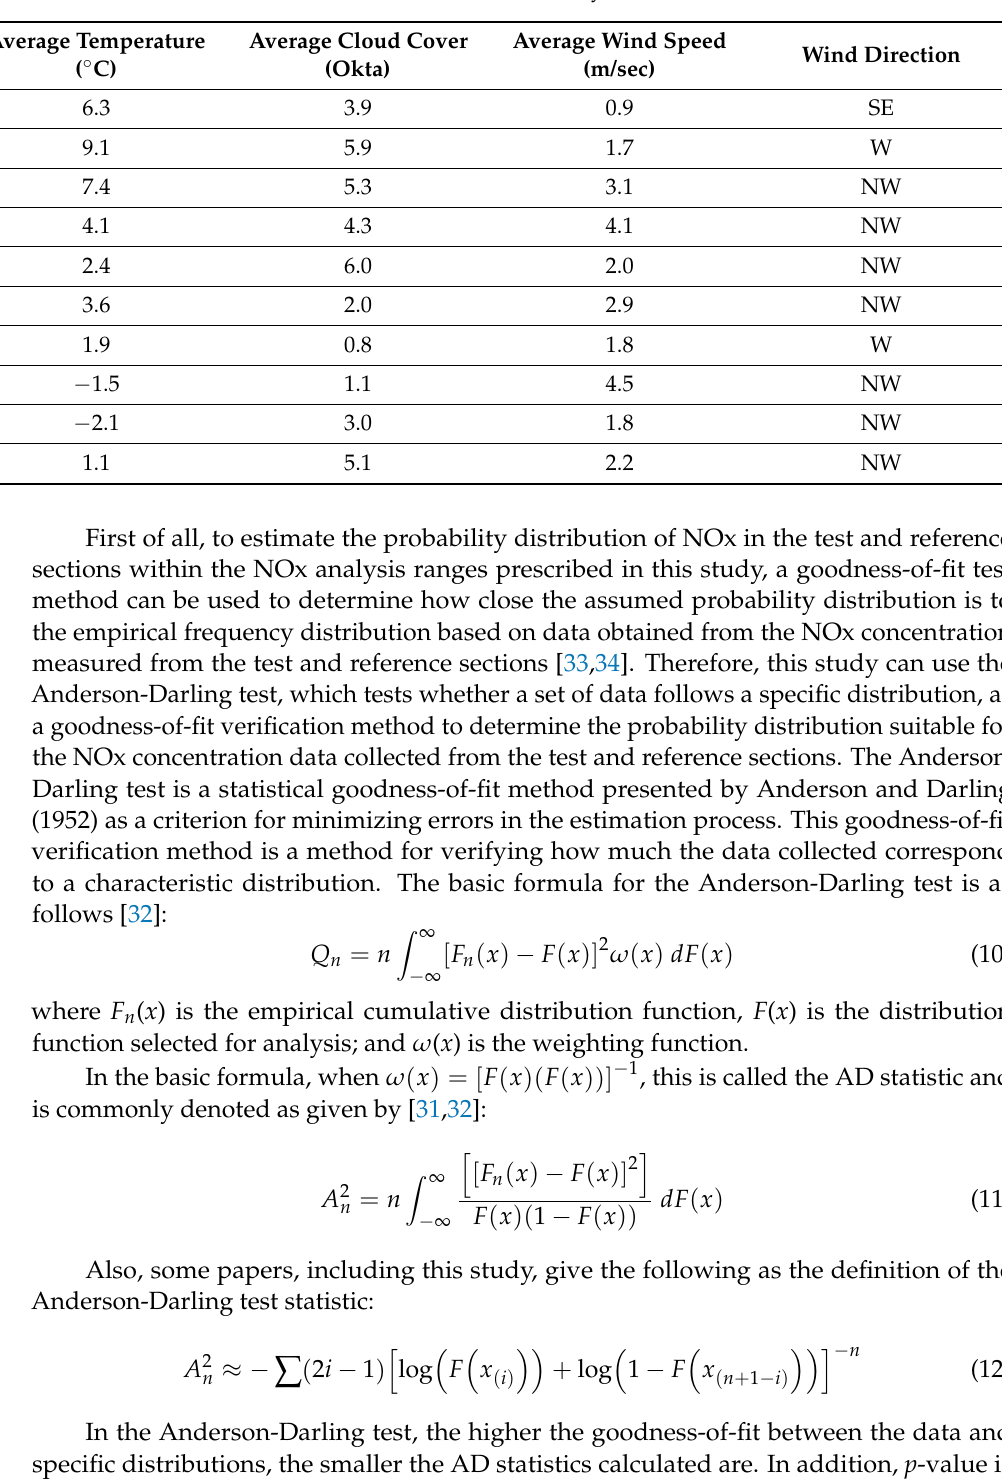
Table 2. Weather Information of Measurement